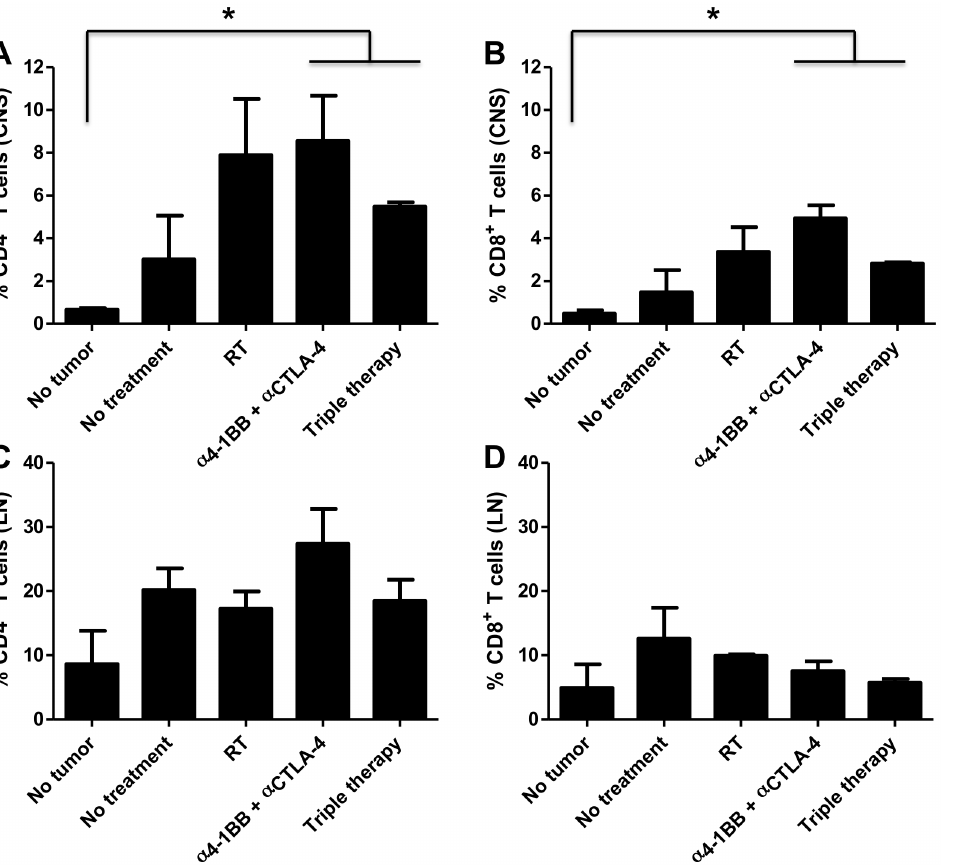
Figure 4. Triple therapy leads to increased CD4 + and CD8 + infiltrating lymphocytes in the brain. A, B) Influx of CD4 + and CD8 + tumor infiltrating lymphocytes respectively was higher in brains of animals treated with immunotherapy with 4-1BB activation and CTLA-4 blockade and triple therapy compared to brains from non-tumor bearing mice ( p , 0.05). C, D) Cervical lymph nodes from naı¨ve mice showed a higher baseline of CD4 + and CD8 + T cells which resulted in comparable densities of T cells between all groups. Error bars represent standard error of the mean (SEM) and p values were calculated with the student t-test.